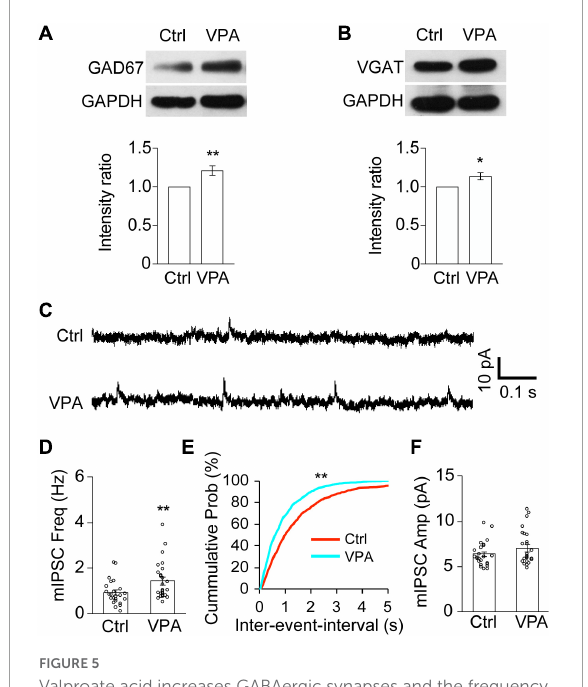
FIGURE5 Valproate acid increases GABAergic synapses and the frequency of mIPSCs. (A,B) Western blot analysis and data summary show that the relative intensities of GAD67 (A) and VGAT (B) to GAPDH were significantly increased in VPA-reared tadpoles compared to Ctrl. GAD67, N = 6; VGAT, N = 6. N represents the number of independent experiments. * p < 0.05, ** p < 0.01. (C) Representative traces were showing the recordings of mIPSCs from Ctrl and VPA-treated animals. Scale bar = 10 pA, 0.1 s. (D–F) The data shows that the frequency of mIPSCs was significantly increased in VPA-reared tadpoles compared to control tadpoles (D) . ** p < 0.01. The cumulative probability plot shows that the inter-event-interval of mIPSCs was significantly decreased in VPA-treated tadpoles compared to ctrl (E) . Kolmogorov–Smirnov test, ** p < 0.01. The data shows that the amplitude of mIPSCs was not altered in VPA-reared tadpoles compared to control tadpoles (F) . Ctrl, N = 24, n = 5; VPA, N = 24, n = 4. N represents the number of neurons and n represents the number of